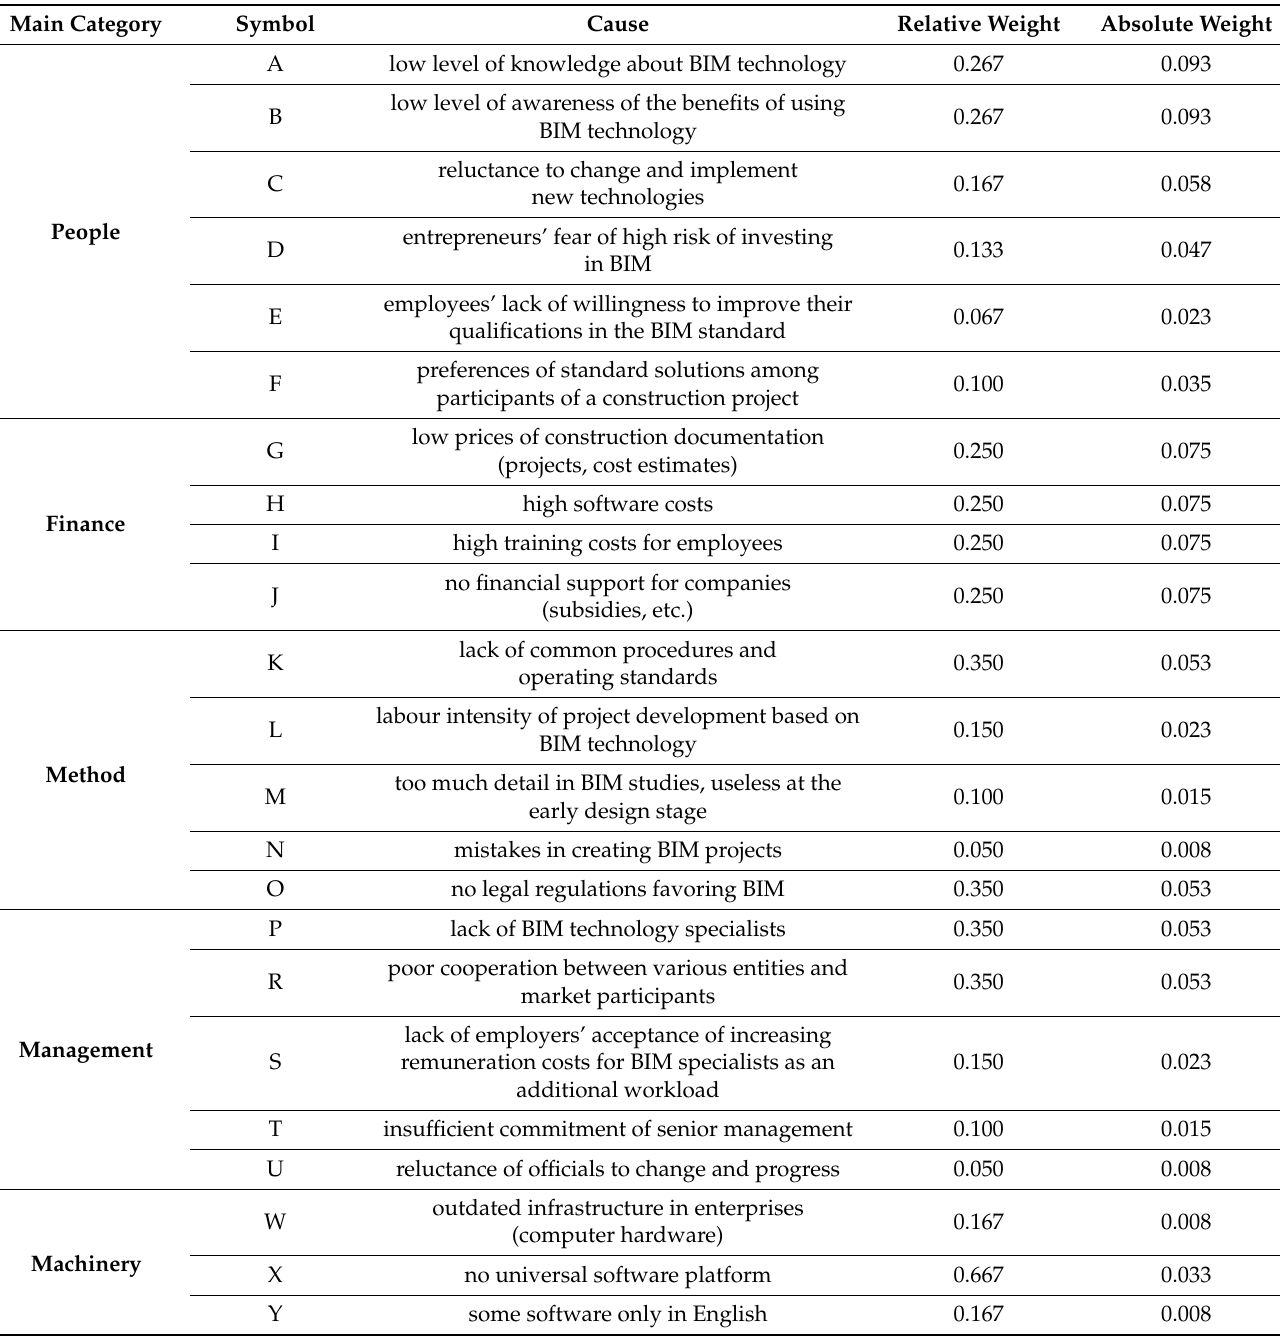
Table 4. Factor relative and absolute weights of